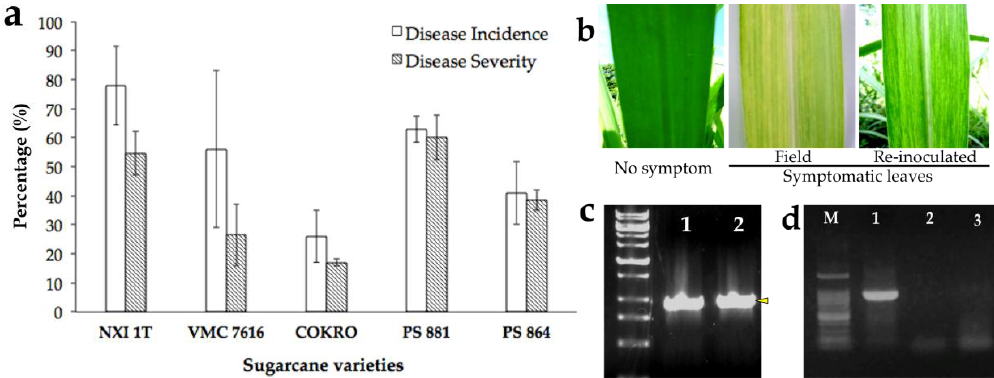
Figure 1. Disease incidence and severity were estimated on several cultivars of sugarcane in the field ( a ). Some leaves showed mosaic symptoms ( b , middle and left). RT-PCR result of naturally occurring symptomatic plant (lane 1), and from re-inoculated sugarcane leaf (lane 2) of cultivar PS 881 using specific primer for Sugarcane mosaic virus (SCMV) ( c ), and RT-PCR result of symptomatic NXI-1T leaves (used as sap) using SCMV primer (lane 1) and Sugarcane streak mosaic virus (SCSMV) primer (lane 2) and on non-inoculated PS 881 leaves (lane 3) ( d ) used in this experiment.